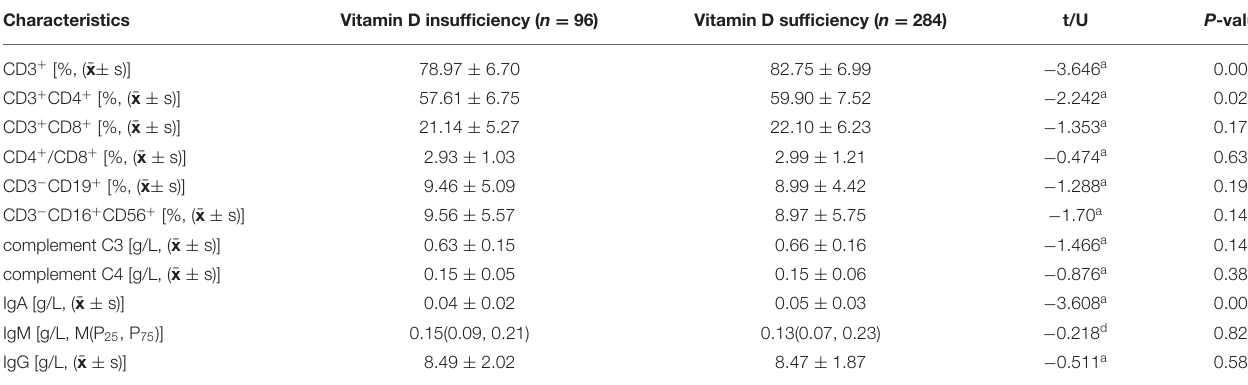
TABLE 6 | Correlation of serum vitamin D with immunological indicators.